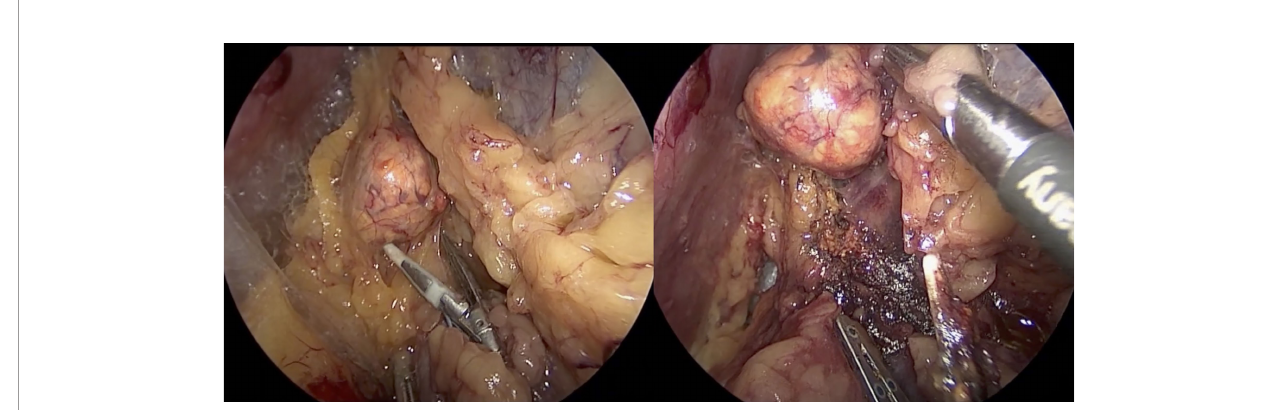
FIGURE 3 | Tumor located on the upper pole on the right side: the dissection of the lower part of the adrenal gland is